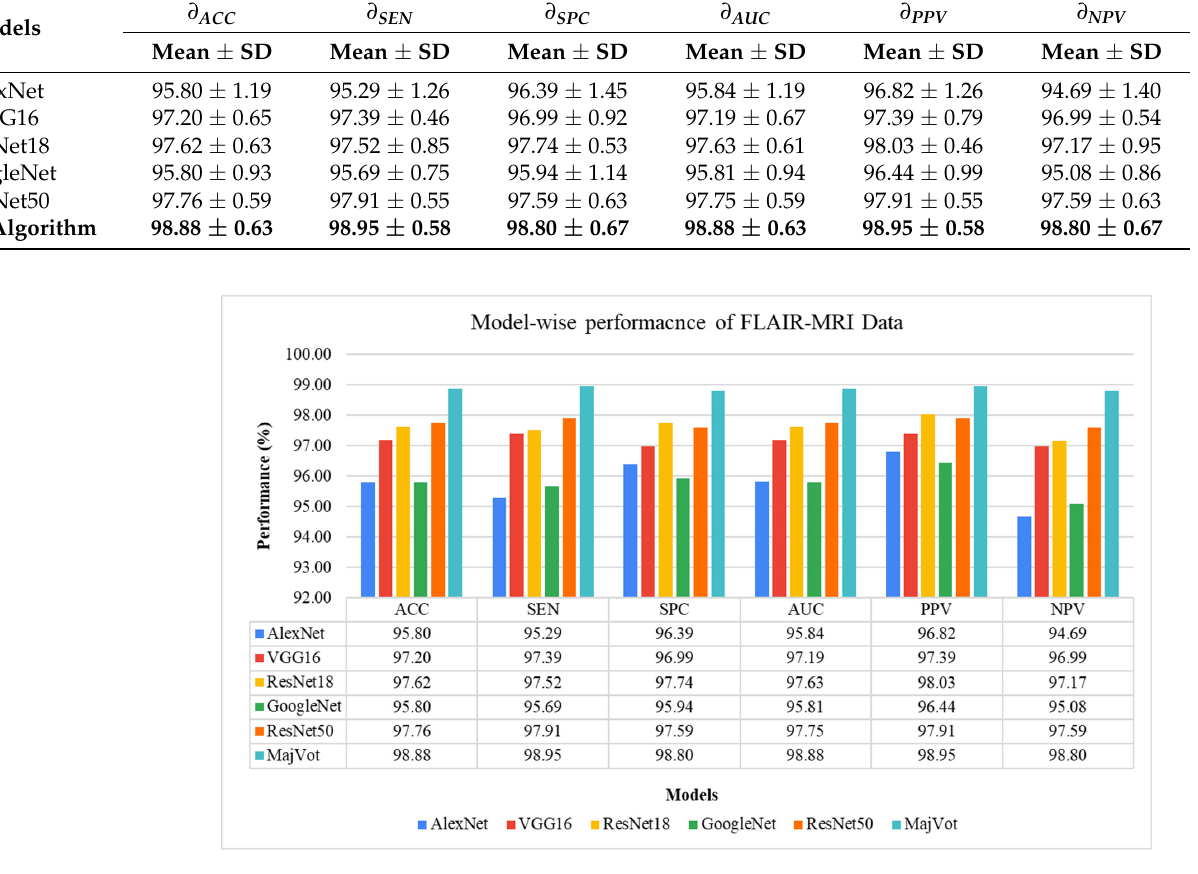
Figure 11. Five-fold test performance of FLAIR-MRI Data.